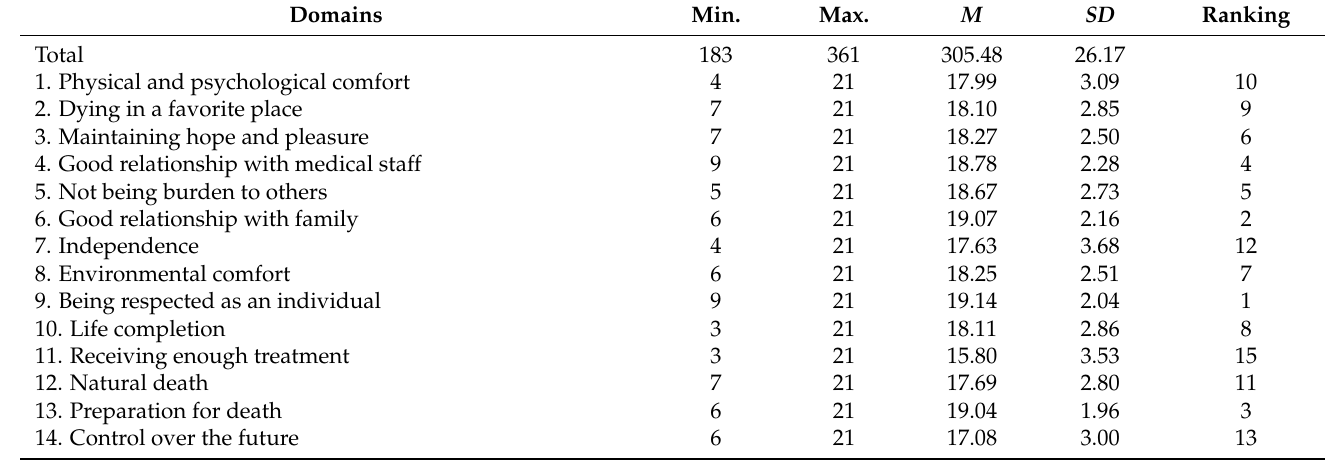
Table 3. Perception of good death of participants (n =